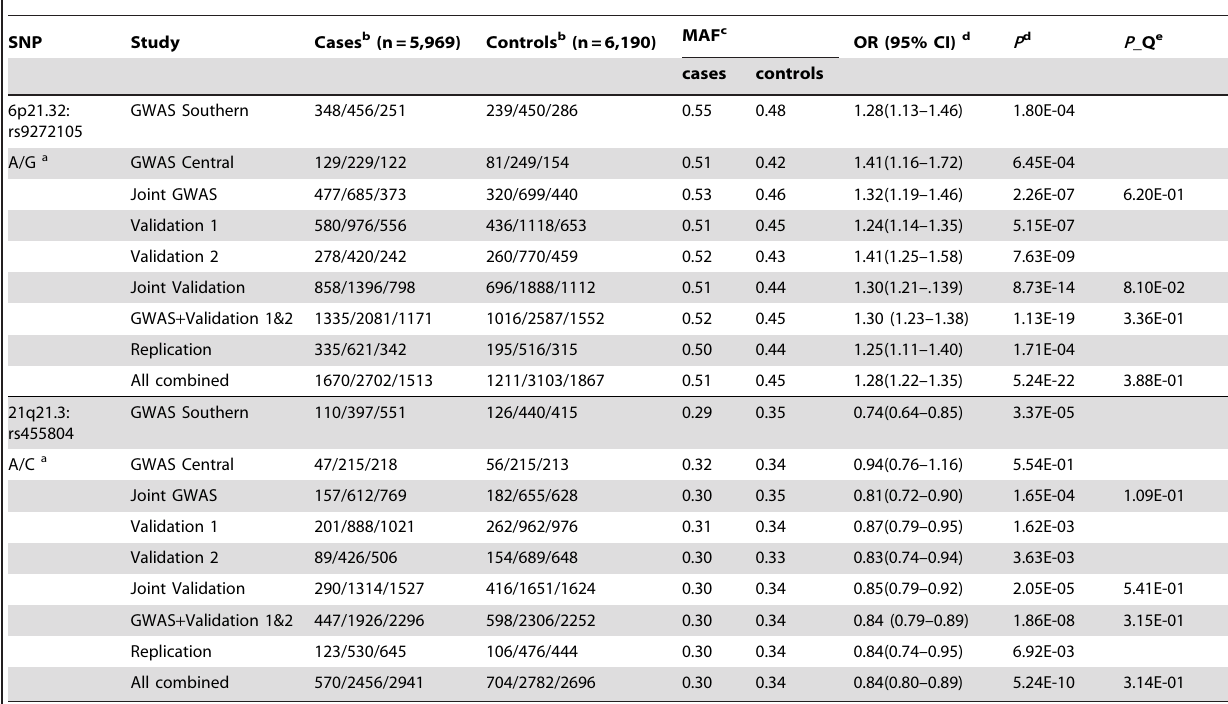
Table 1. Summary of GWAS scan, validation, and replication studies for the 2 SNPs.